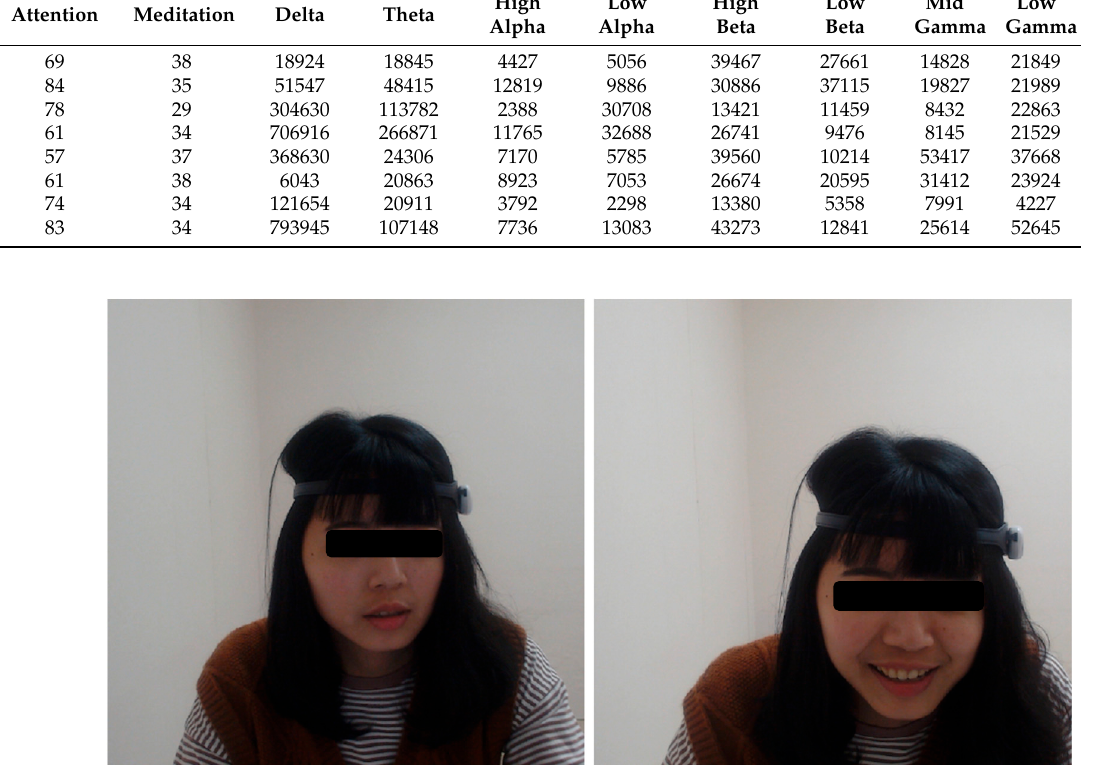
Table 6. Derived EEG powers dataset (part).